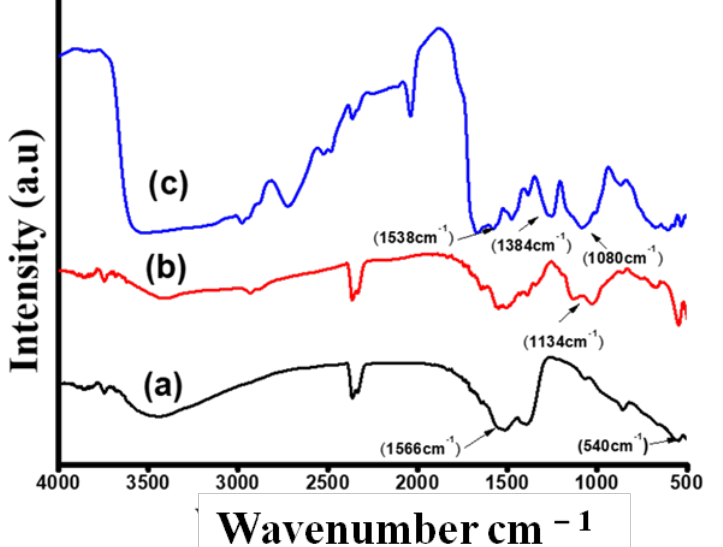
Figure 5. FTIR spectra of ( a ) bare Gd 2 O 3 ;( b ) APTES-Gd 2 O 3 /ITO; ( c ) anti-CT/APTES-Gd 2 O 3 /ITO.